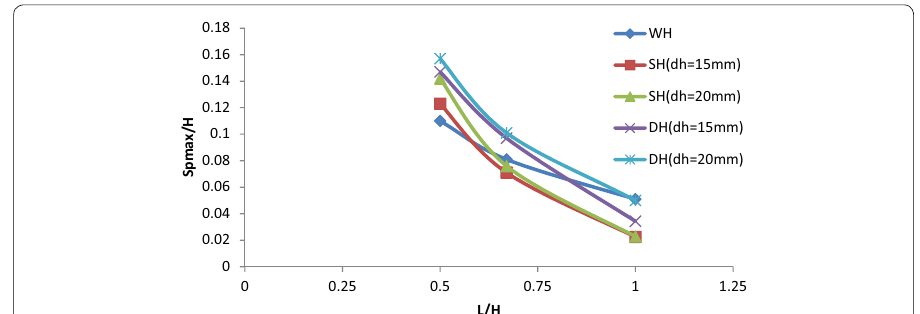
Fig. 12 Variation of ratio (Spmax/H) with (L/H) ratio of helical pile with different lengths and helix diameters